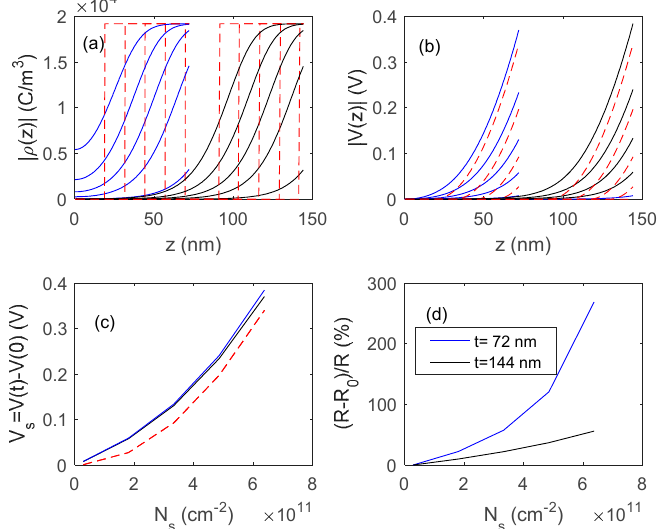
Figure 15. Distribution of the charge density ρ (plot ( a )), and of the voltage (plot ( b )) inside the film as a function of z for different values of charged surface species density, N s , and for two films thickness, 72 nm and 144 nm. N s in the range 0.1 × 10 11 cm − 2 –6.3 × 10 11 cm − 2 . ( c ) Surface voltage barrier as a function of the density of charged surface species. Solid lines: proposed model, dashed lines: fully depleted model. ( d ) Sensor responses to the variation of surface charge density. Data for In 2 O 3 are taken from [28,29] N d = 1.2 × 10 17 cm − 3 .